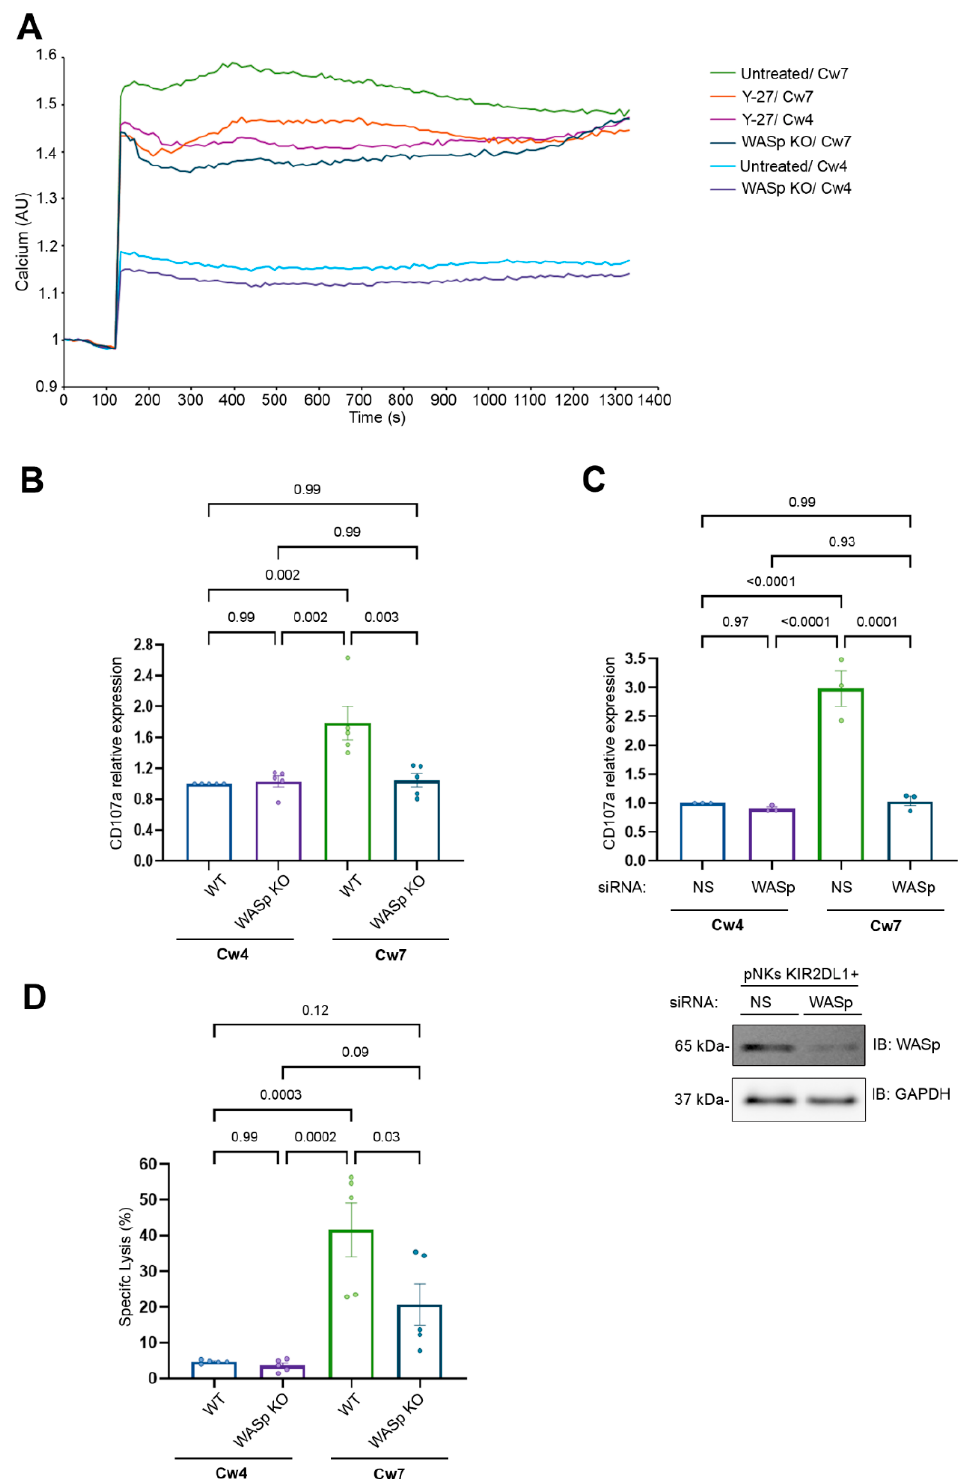
Figure 4. F-actin flow dynamics dictate the NK cell activation threshold. ( A ). YTS-2DL1, YTS-2DL1 treated with Y-27; WASp KO cells were loaded with Indo-1-AM and basal intracellular calcium levels were measured for 60 s. The target cells (221-Cw4 or 221-Cw7) were then added to the effector cells and incubated at 37 ◦ C. Following 5-min incubation, the calcium levels were further analyzed by spectrofluorometer. A representative experiment of at least three independent experiments is